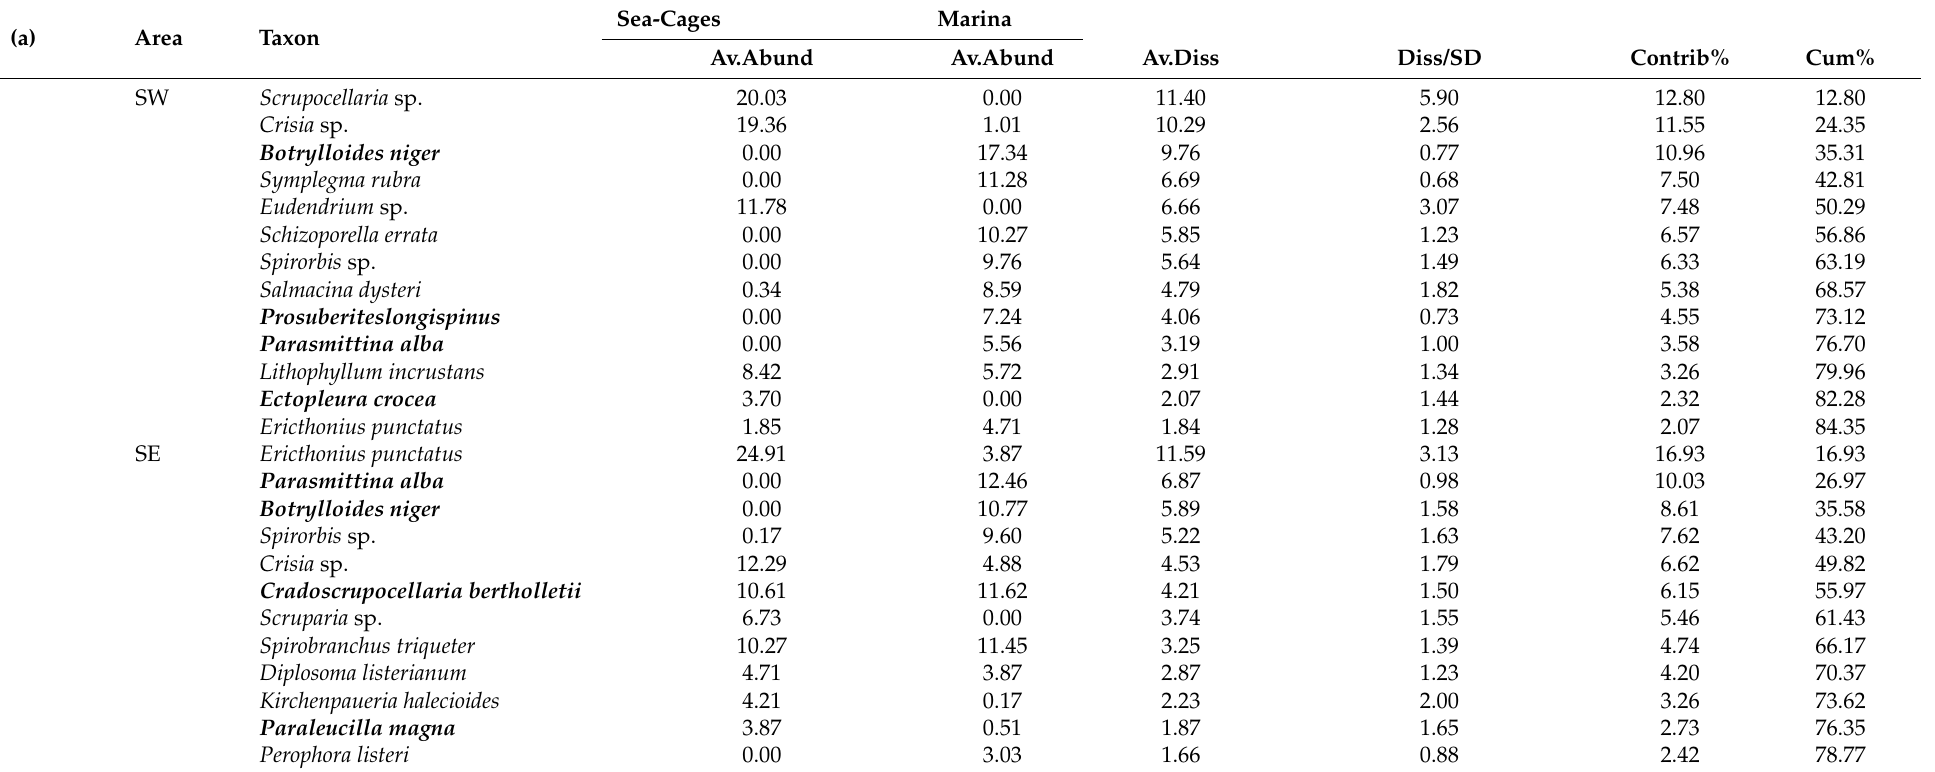
Table 3. Results from SIMPER analysis showing the contribution of taxa to the average Bray–Curtis dissimilarity ( a ) and similarity ( b ) between fouling communities fixed on the experimental plates at sea-cages and marinas from two regions on the south coast of Madeira (SW vs. SE). The individual taxa cut-off level was ≥ 2% for dissimilarity and similarity analyses. Non-indigenous species are highlighted in